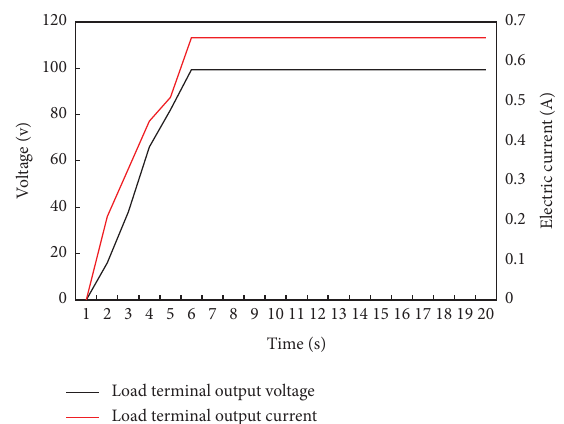
Figure 7: Output current and voltage waveforms at 25% of the rated